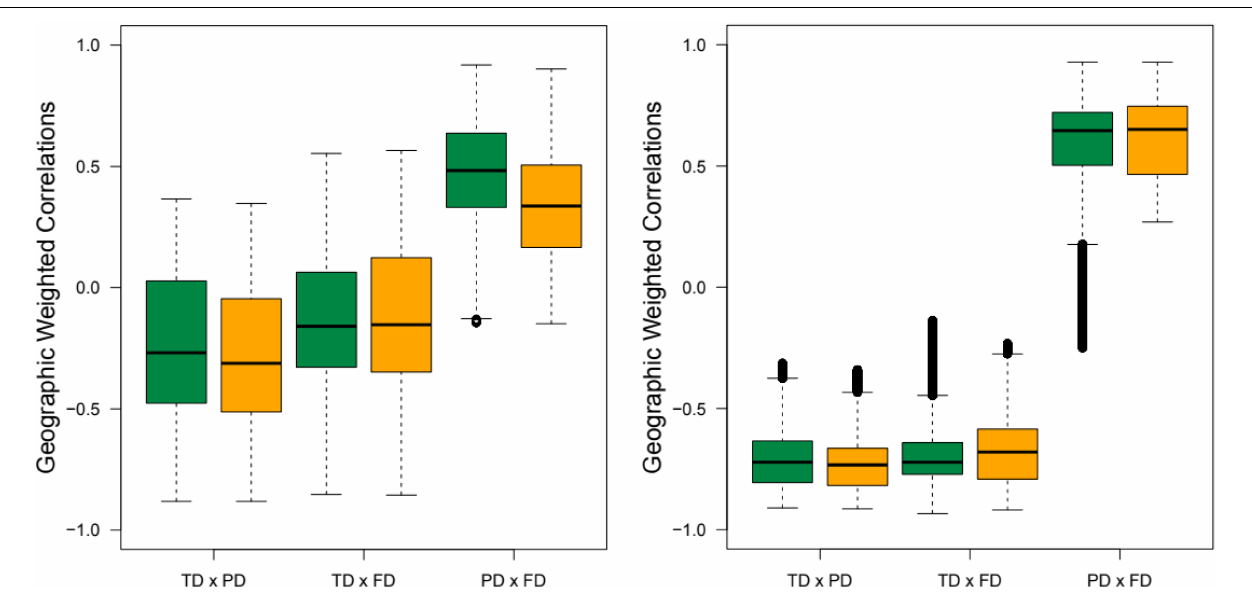
FIGURE 5 | Geographic weighted correlations among taxonomic, phylogenetic and functional diversity between rainforests (green) and seasonally dry forests (yellow). The boxplot represents the mean correlation among the pixels classified in each ecosystem for MPD (right) and MNTD (left). All comparisons yielded a p < 0.001 ( Supplementary Table 4